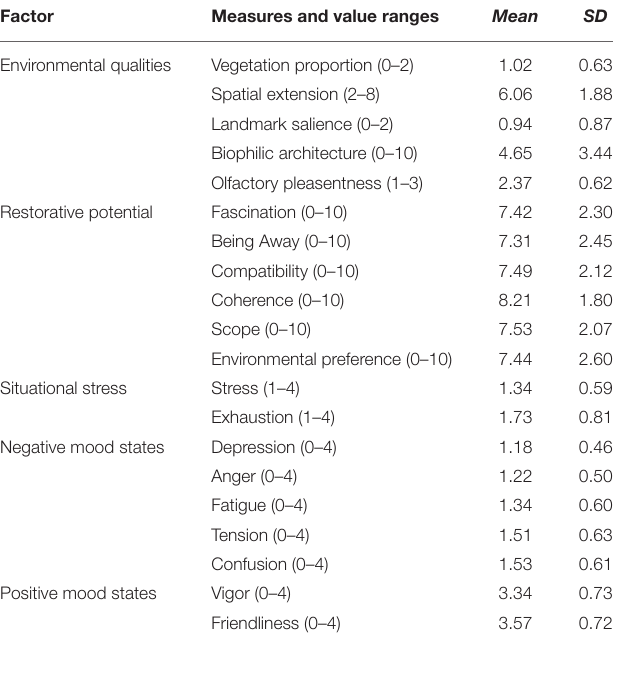
TABLE 7 | Descriptive statistics of the factors included in the model. Factor Measures and value ranges Mean SD Environmental qualities